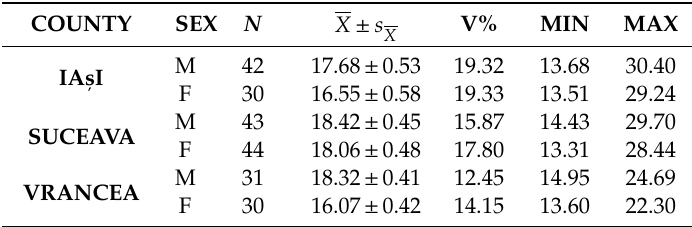
Table 3. Distribution of results according to gender and